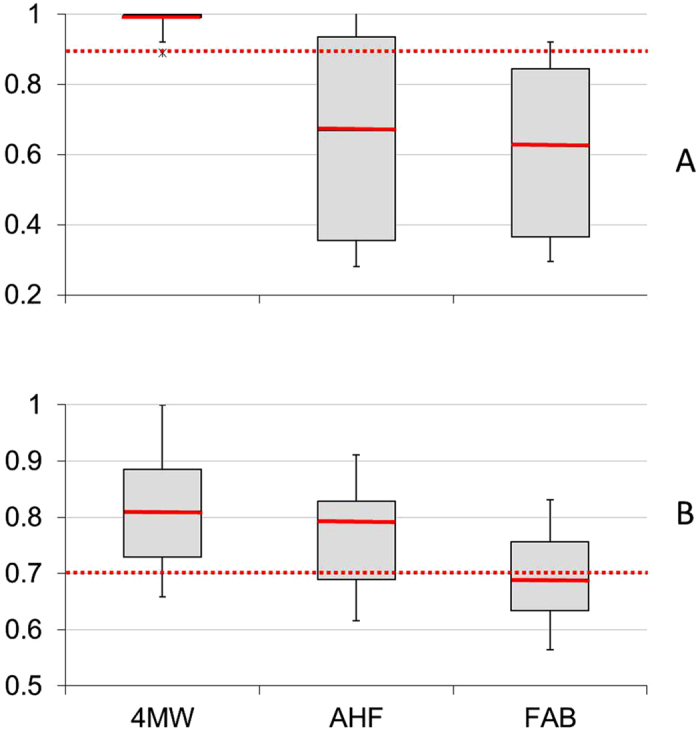
Boxplots of relative performance of three models (4MW, AHF, FAB) for predicting severe cyclone damage for 7 TCs where extensive field survey data was available (see text for description of data sets).(A) shows the true positive rate with a performance benchmark of 0.9 (red dotted line). (B) shows partial AUC with a standard performance benchmark of 0.7 (red dotted line).